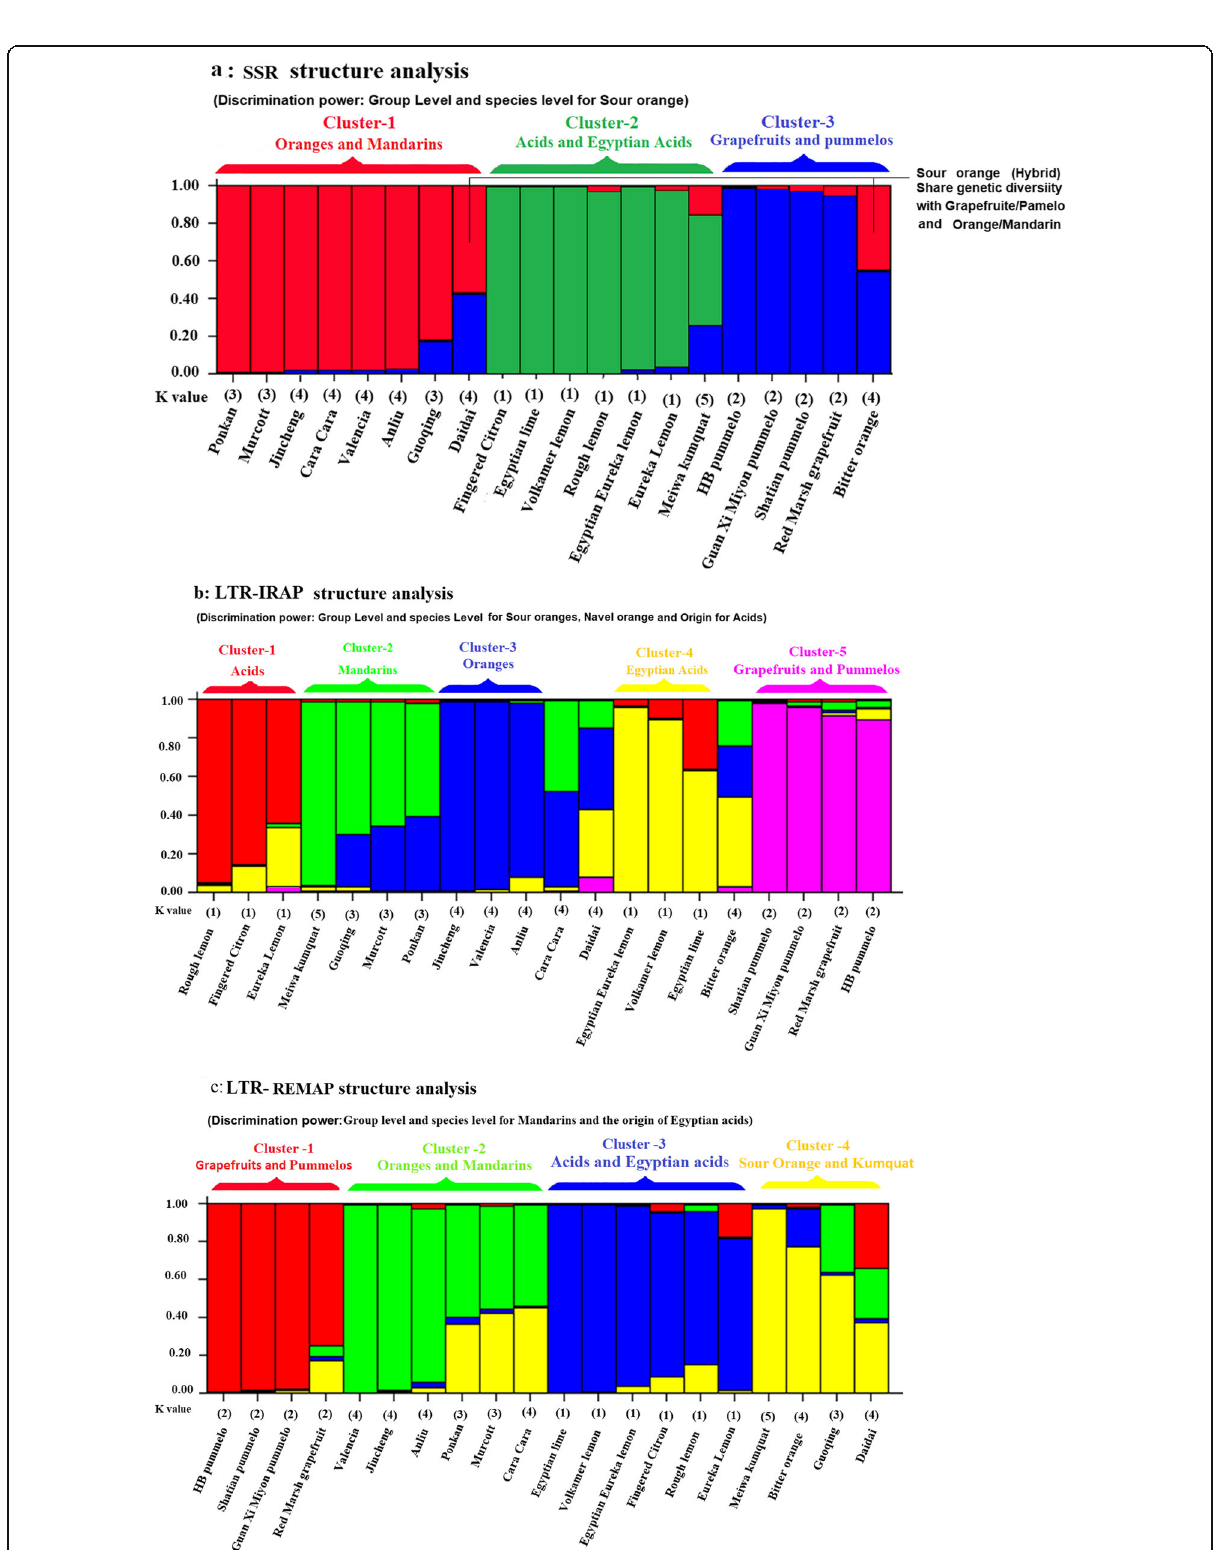
Fig. 4 Structure bar plot graph of 20 genotypes of citrus and its relatives species, a SSR marker K = 3, b LTR-IRAP marker K = 5, and c LTR-REMAP marker K = 4. Samples are ordered by group